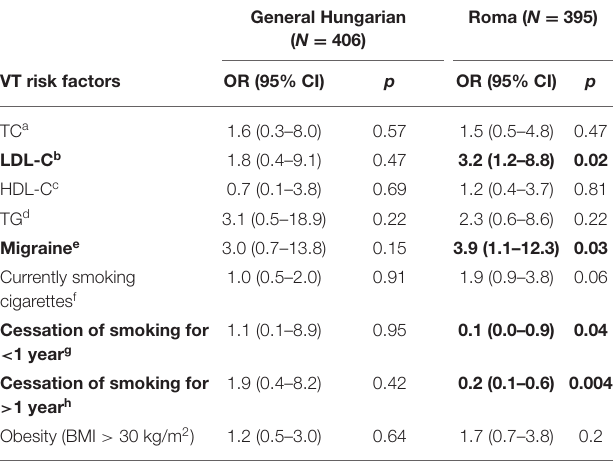
TABLE 6 | Association between uGRS and VTE risk factors. General Hungarian Roma ( N = 395) VT risk ( N = 406)